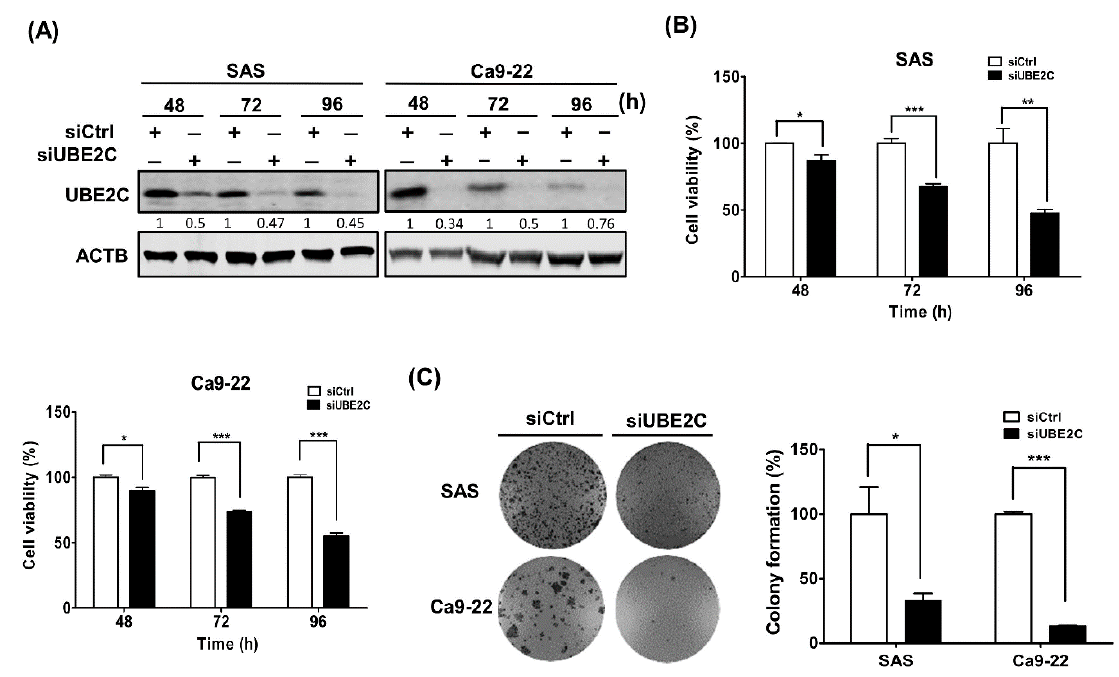
Figure 2. Cell viability and colony formation in UBE2C-knockdown SAS and Ca9-22 cells. ( A ) UBE2C knockdown efficiency of cells transfected with scrambled siRNA (5 nM, siCtrl) or siRNAs against UBE2C (5 nM, siUBE2C) for 48, 72 and 96 h was analyzed by western blot analysis. ( B ) The viability of cells transfected with scrambled siRNA (5 nM, siCtrl) or siRNAs against UBE2C (5 nM, siUBE2C) for 48 h was measured by Cell Titer Glo. ( C ) The colony formation of cells transfected with scrambled siRNA (5 nM, siCtrl) or siRNAs against UBE2C (5 nM, siUBE2C) was monitored for 1–3 weeks. The colonies of UBE2C-knockdown cells are shown in the left panel and their quantification is shown in the right panel. The quantitative results are expressed as the mean ± SD from three independent experiments. * p < 0.05, ** p < 0.01 and *** p < 0.001 vs. nontargeting control siRNA (siCtrl).